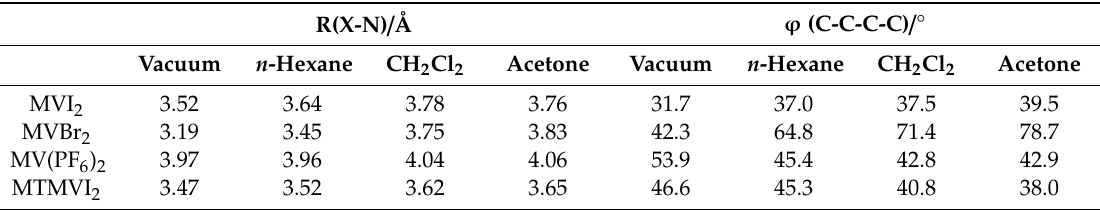
Table 2. Some relevant geometrical parameters of the systems